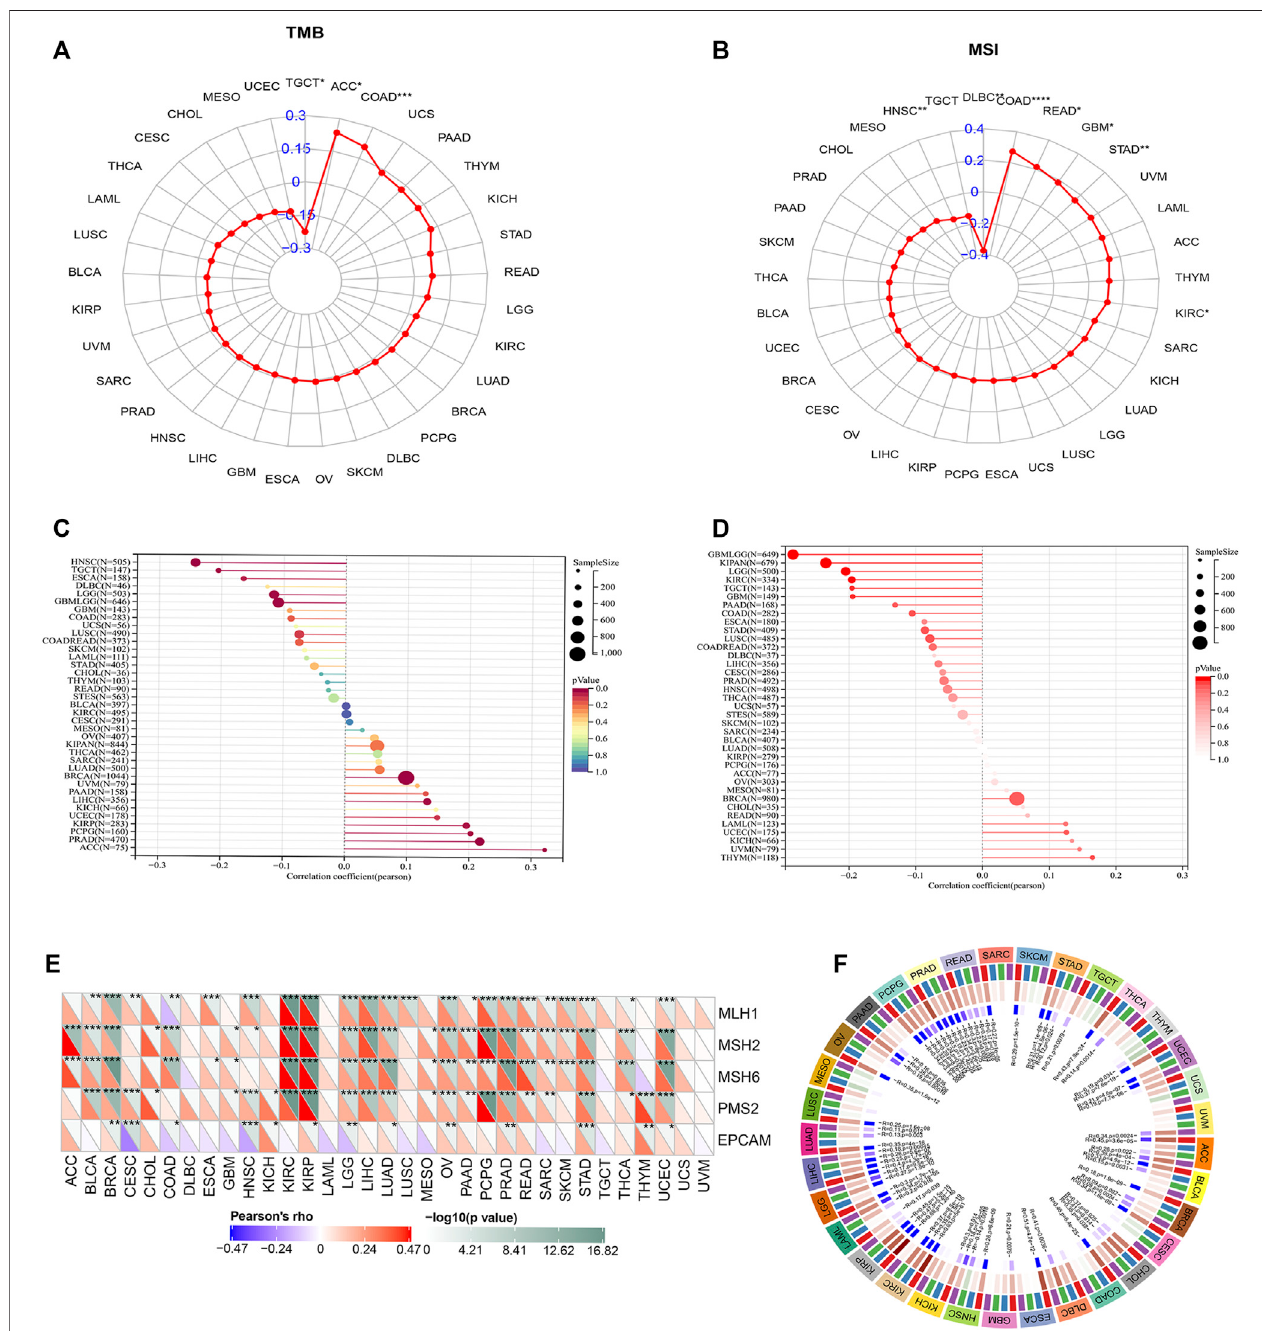
FIGURE 7 | (A) Radar plot showing the correlation between OAS3 expression and TMB in pan-cancer. The blue number represents Spearman ’ s correlation coef fi cient. p p < 0.05, pp p < 0.01, ppp p < 0.001. (B) Radar plot showing the correlation between OAS3 expression and MSI in pan-cancer.The blue number represents Spearman ’ s correlation coef fi cient. p p < 0.05, pp p < 0.01, ppp p < 0.001. (C) The correlation between OAS3 expression and HBD in pan-cancer. The size of the circle represents the number of samples. The colors represent signi fi cant p -values ( p < 0.05) for each section; red low p -value, blue high p -value. (D) Relationship betweenOAS3andheterogeneity.Thesizeofthecirclerepresentsthenumber ofsamples.Colorrepresents p -value,thedarkerthecolorthemoresigni fi canttheresult. (E) OAS3wascloselyassociatedwithDNAMMRgenes.Theuppertriangleofeachsquarerepresentedthemagnitudeofthe p valueofthecorrelationtest,andthelower triangle represented the correlation coef fi cient. * p < 0.05; ** p < 0.01; *** p < 0.001. (F) OAS3 was positively correlated with four major DNA methyltransferases including DNMT1, DNMT2, DNMT3A, and DNMT3B in most cancer types.